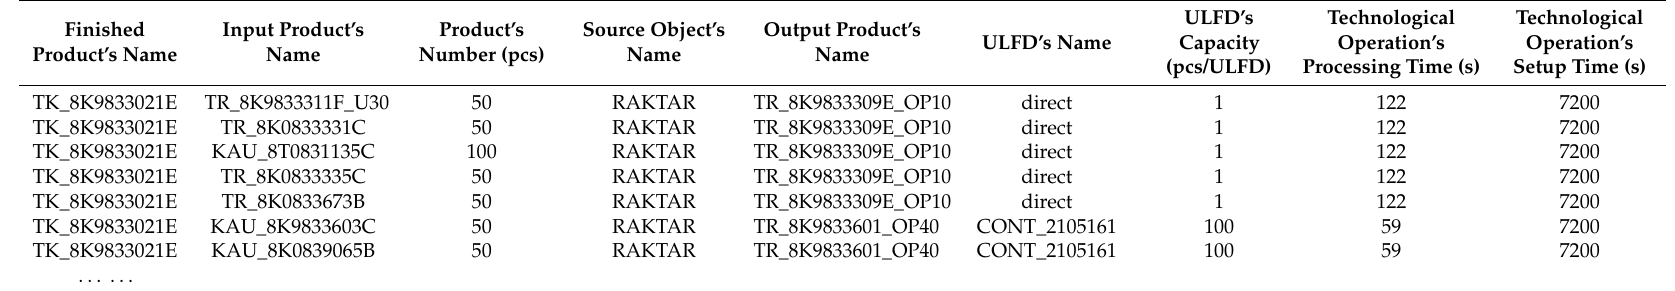
Table 11. Technological operations data table for operation